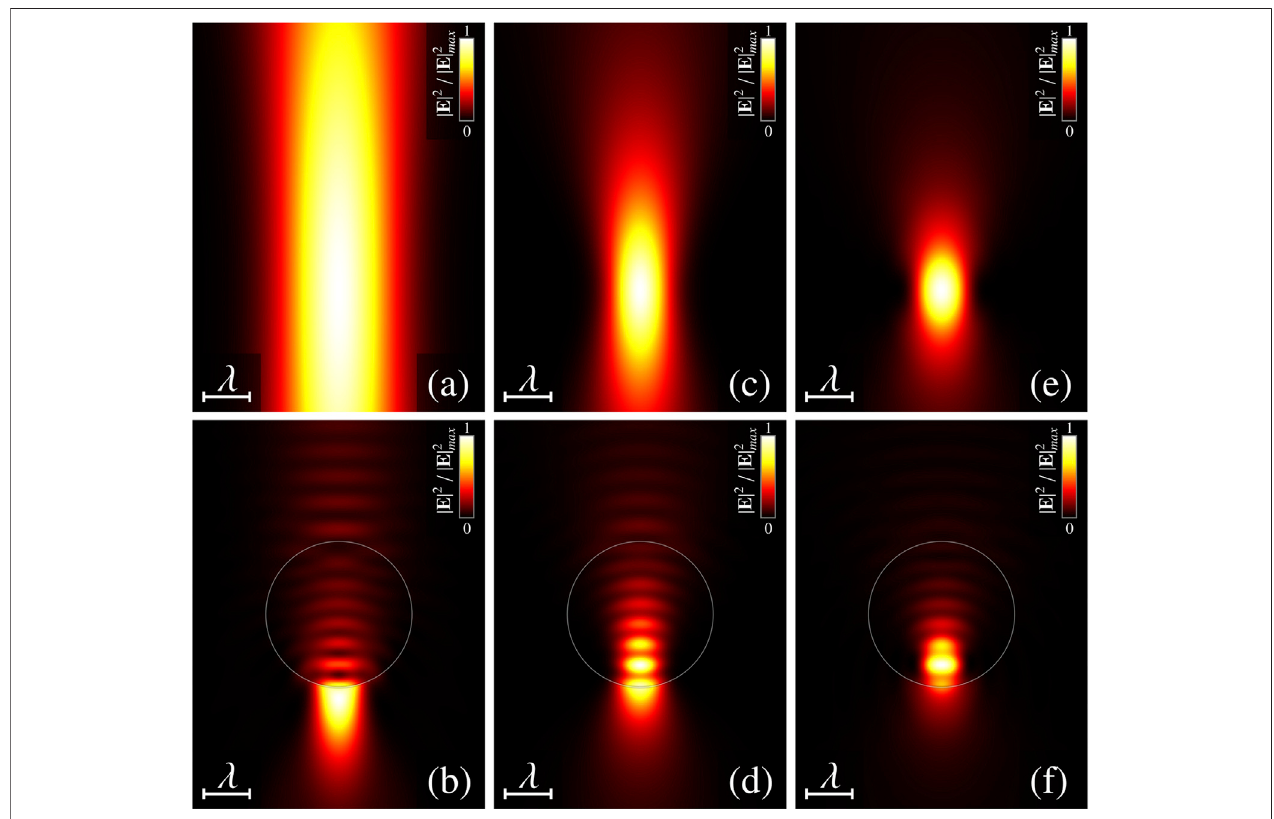
FIGURE 2 | Diffraction on the dielectric spherical particle: near- fi eld intensity distributions in the x - z plane (B, D, F) and freely propagating wave (A, C, E) . The incident wave is a non-vortex Gaussian beam ( LG 0,0 ). z b (cid:2) 1.5 λ , R p (cid:2) 1.5 λ , and n r (cid:2) 1.3. (A, B) — f (cid:2) 0.1, (C, D) — f (cid:2) 0.2, and (E, F) — f (cid:2) 0.3.